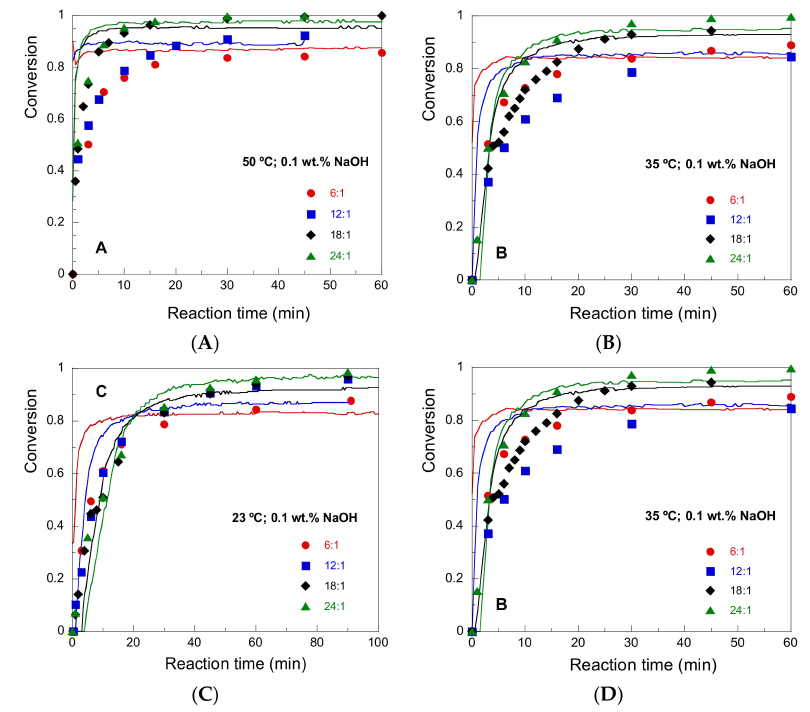
Figure 6. Experimental conversion evolution (symbols) and conversion calculated from experimental sound velocity (lines) for ethanolysis carried out at different alcohol/oil molar ratios and catalyst contents. In ( A – C ) are shown runs performed with 0.1 wt.% NaOH; ( A ) at 50 ◦ C, ( B ) at 35 ◦ C, and ( C ) at 23 ◦ C. ( D ) show results from tests carried out at 23 ◦ C and 0.05 wt.%